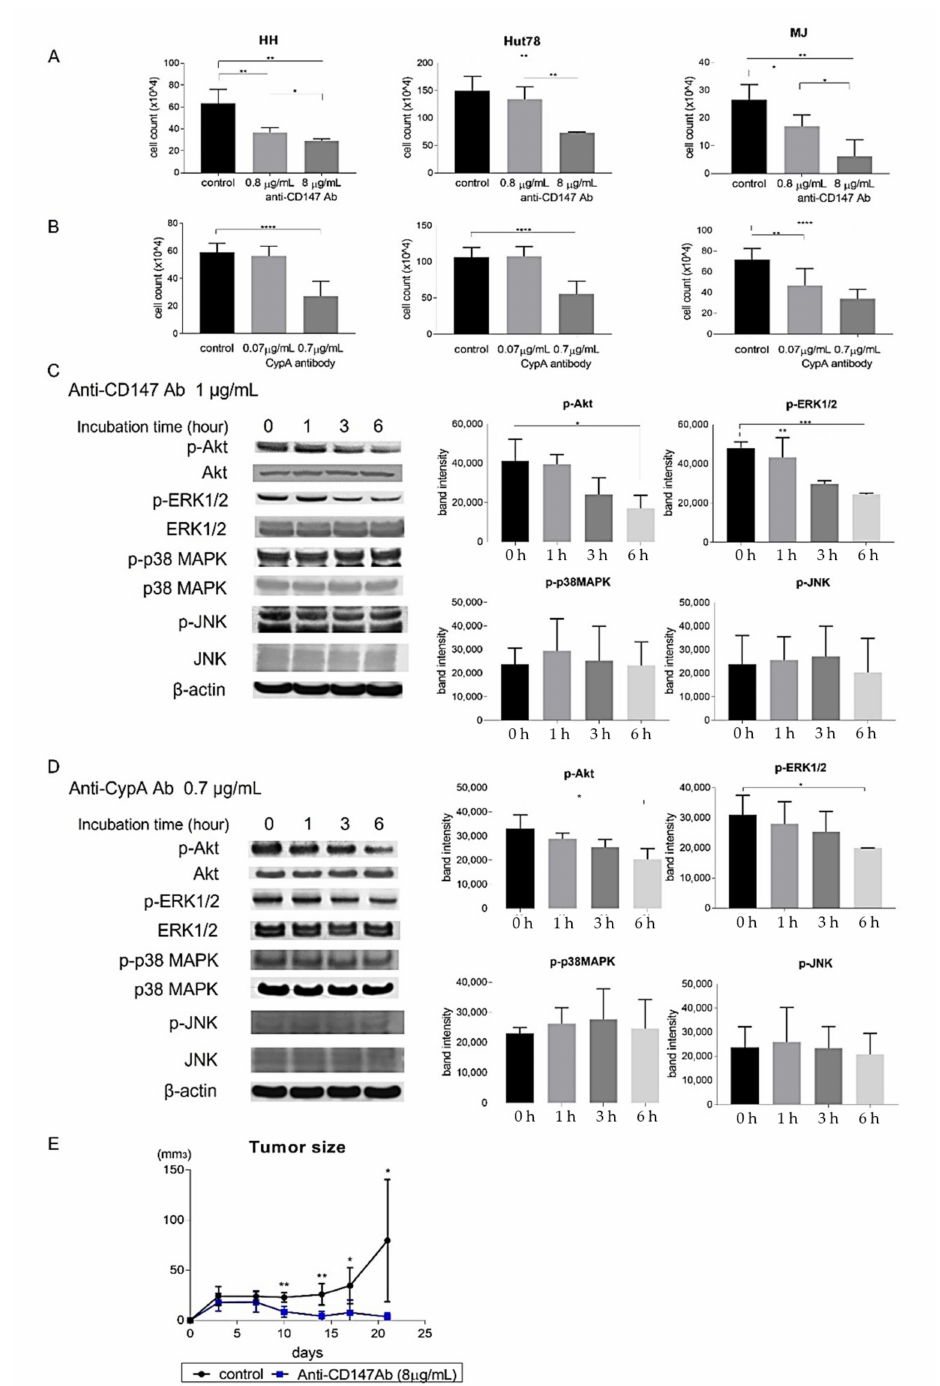
Figure 4. CD147-CypA interactions promoted the proliferation of cutaneous T-cell lymphoma (CTCL) cell lines. ( A , B ) CTCL cell lines (HH, Hut78, and MJ cells) were cultured with anti-CD147 antibody (0.8, 8 µ g/mL) or anti-CypA antibody (0.07, 0.7 µ g/mL) for 48 h. Viable cells were counted. Data are presented as mean ± standard deviation. ( C , D ) Western blotting analysis was conducted on the lysates of HH cells treated with anti-CD147 antibody (1 µ g/mL) or anti-CypA antibody (0.7 µ g/mL) for 0, 1, 3, or 6 h. Phosphorylation of AKT, ERK1/2, p38 MAPK, and JNK was measured. A representative picture of three independent experiments is shown. Band intensities of phosphorylated AKT, ERK1/2, p38 MAPK, and JNK at each time were calculated by Image J software. n = 3. Data are presented as mean ± standard deviation. ( E ) HH cells (1.0 × 10 7 ) were injected into Scid-beige mice with PBS or anti-CD147 antibody (8 µ g/mL). Each reagent was injected on days 0, 4, 7, 11, 14, and 18. Tumor size was calculated on days 4, 7, 11, 14, 18, and 21. Data are presented as means ± standard error of the mean ( n = 28). * p < 0.05, ** p < 0.01, *** p < 0.005, **** p <